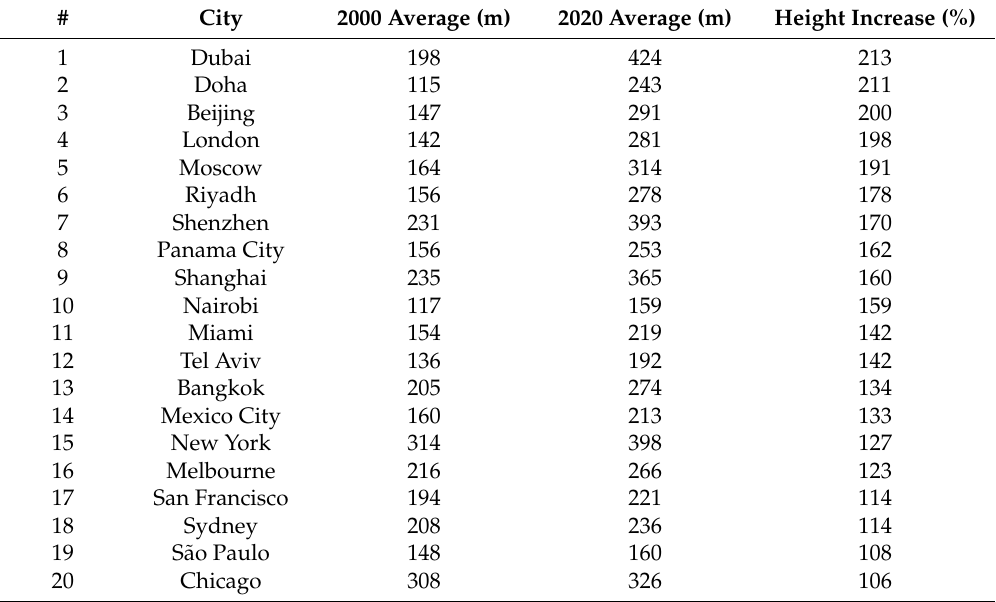
Table 34. Increased height of the 10 tallest skyscrapers in 2000 and